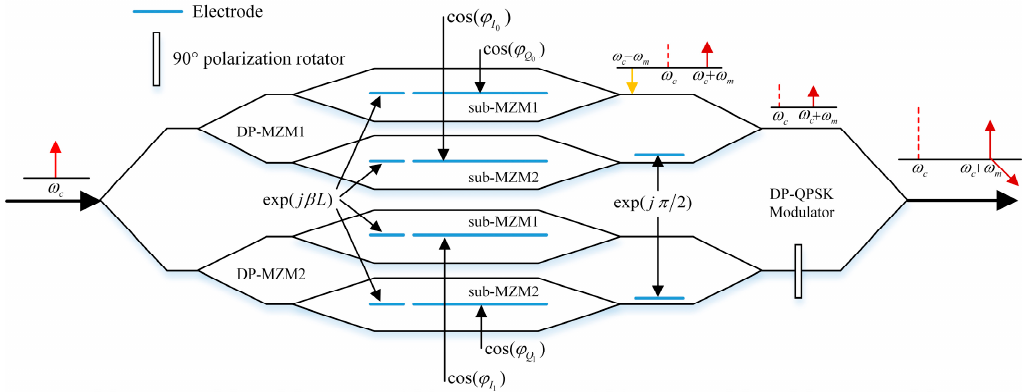
Figure 1. A diagram of the detailed structure of the dual-polarization quadrature phase-shift keying (DP-QPSK) modulator and how it works. DP-MZM: dual-parallel Mach–Zehnder modulator. exp ( j β L ) is the phase shift due to the electrode length. The baseband signal to be modulated is applied to the electrode of the MZM. Each MZM is biased at the minimum transmission point and each DP-MZM is biased on one arm to introduce a 90° phase shift.